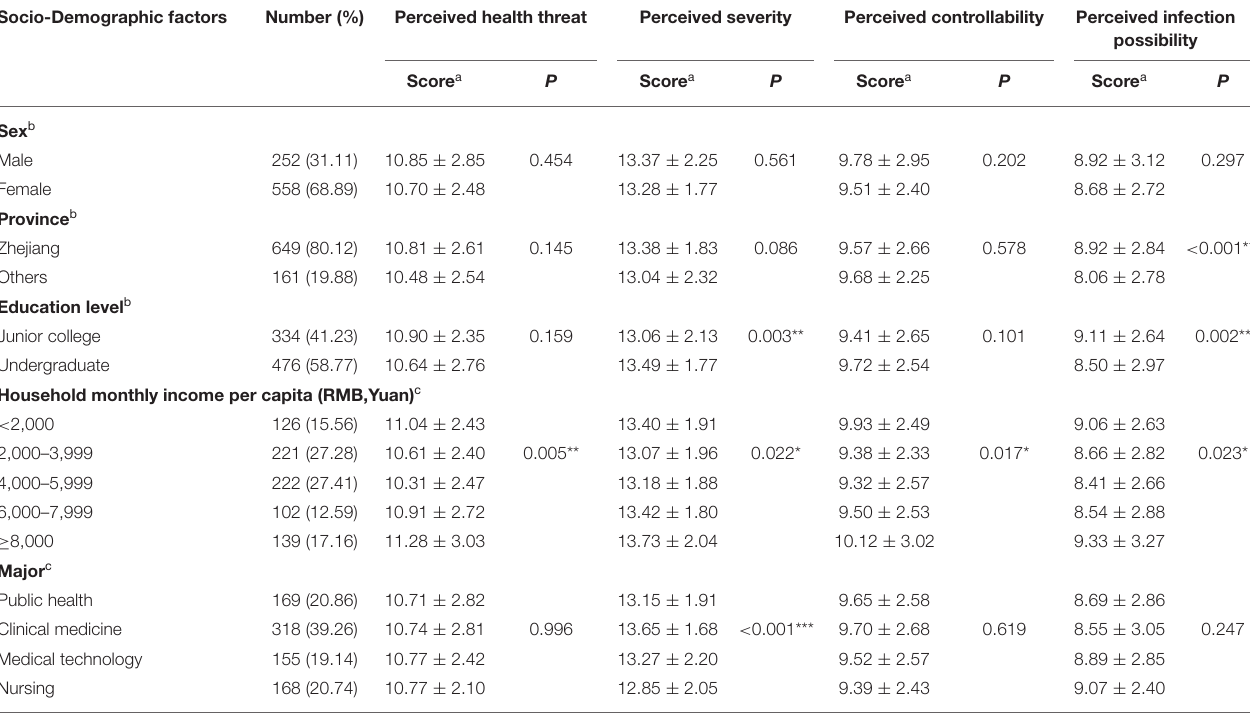
TABLE 2 | Univariate analysis of the risk perception of COVID-19 among medical college students with different socio-demographic factors. Socio-Demographic factors Number (%) Perceived health threat Perceived severity Perceived controllability Perceived infection possibility Score a P Score a P Score a P Score a